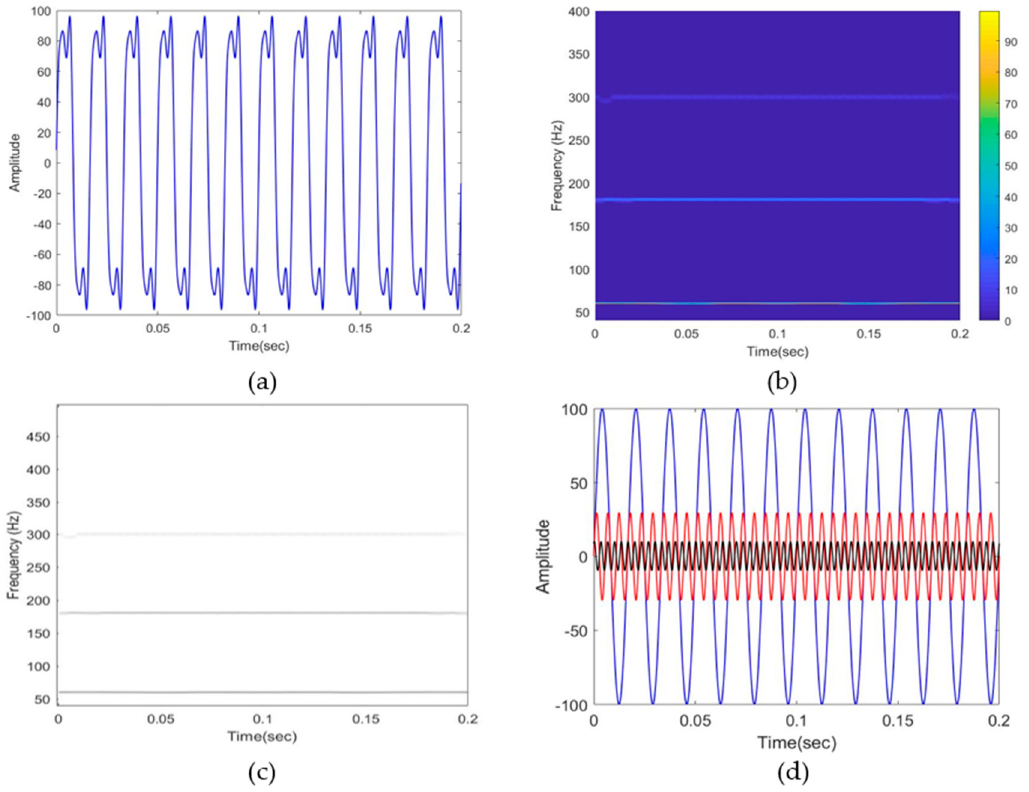
Figure 1. ( a ) Input time-domain signal, ( b ) SSWT modulus, ( c ) the ridges extracted from SSWT, ( d ) signal reconstruction in intrinsic mode functions.